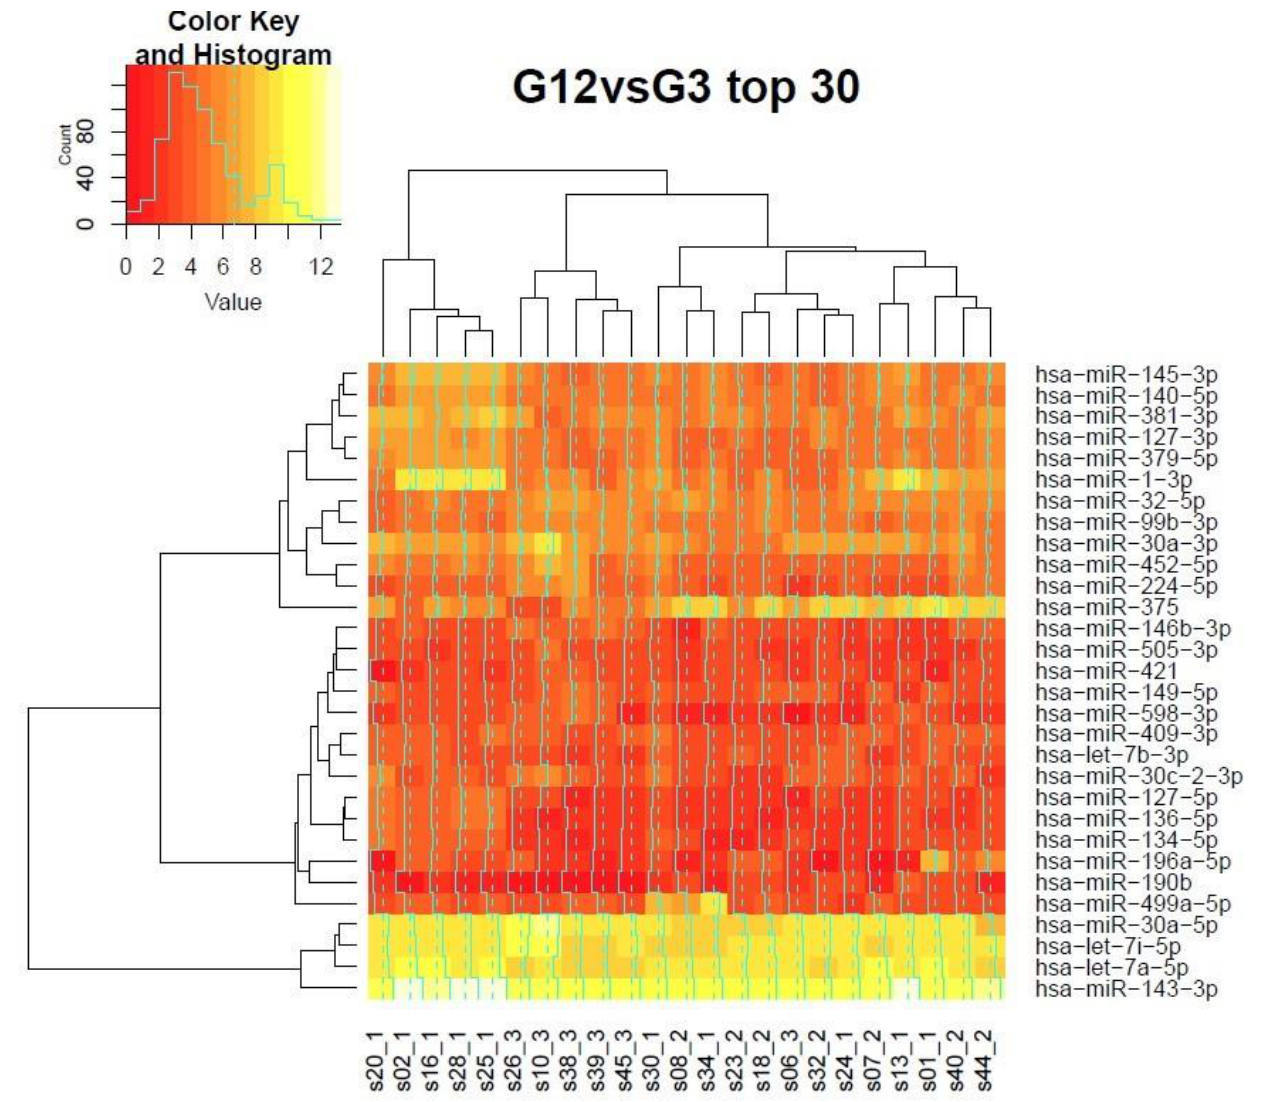
Figure 4. Clustering of the top 30 differentially expressed miRNAs of collected together patients with G1 and G2 grade vs. G3 grade (low grade vs. high grade EC). Clustering includes miR-190b and miR-375. It can be seen that miR-375 clusters differently from other miRNAs. Value = miRNA gene reads. At the bottom of the picture is the sample’s name with grade indication.